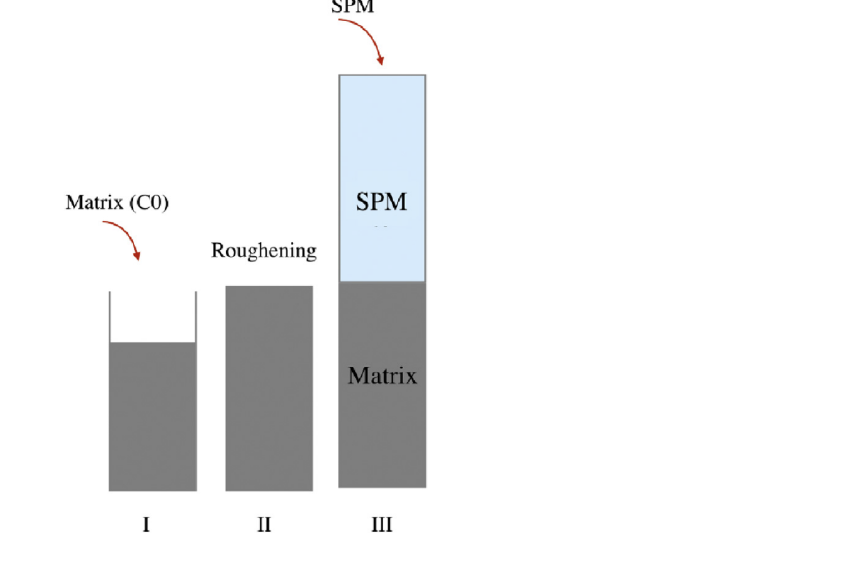
Figure 15. Casting procedure of mortar for the measurement of viscous performance [74].